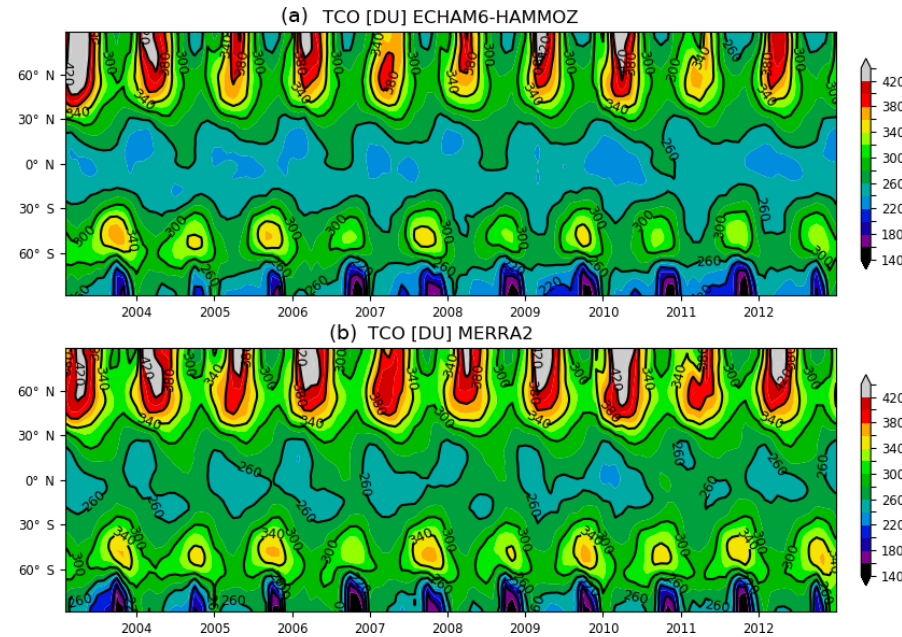
Figure 3. The 10-year latitude–time variations in the total ozone column in ECHAM-HAMMOZ (a) and in the MERRA-2 reanalysis (b) . A difference plot can be found in the